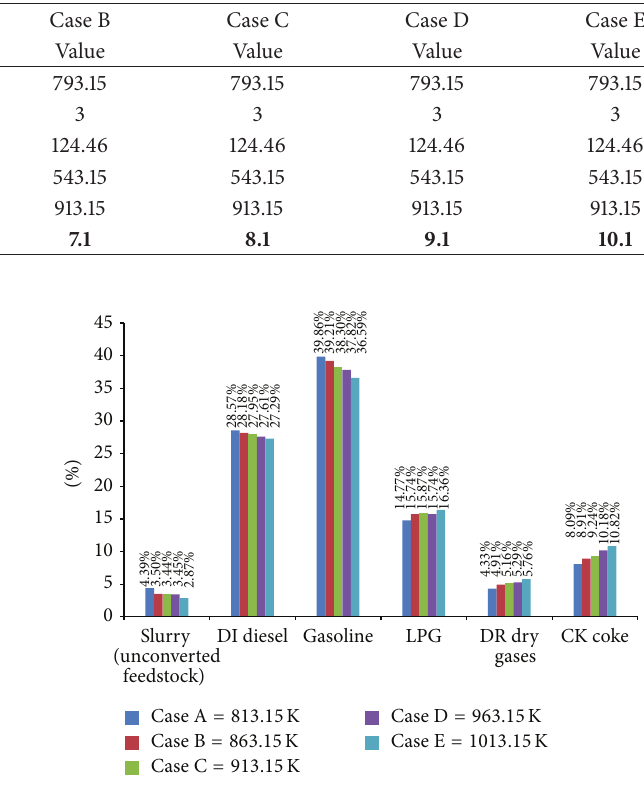
Figure 15: Comparison of the product yields for different catalyst temperatures.